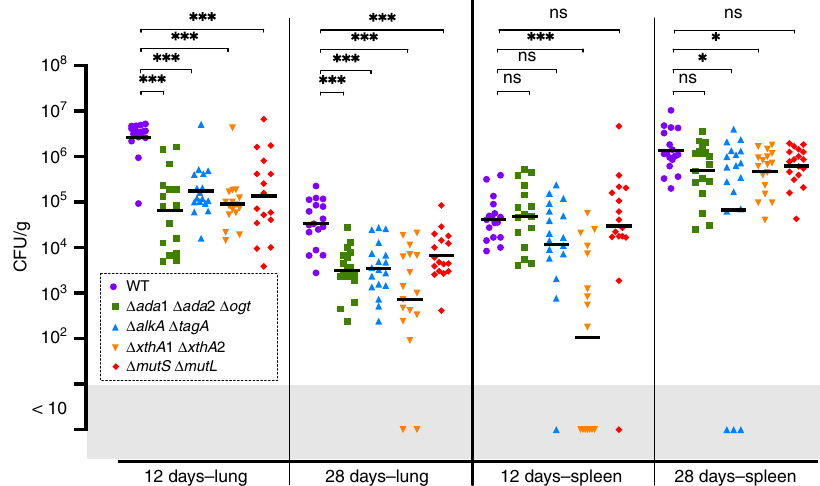
Fig. 8 Intranasal mice infection with B. abortus DNA repair deletion strains. Wild-type C57BL/6 mice received 2 × 10 4 CFU of B. abortus , as indicated in the section “ Methods ” . The mice were sacri fi ced at the selected time post infection. The data represent the number of CFU g − 1 of lung and spleen. These results are representative of two independent experiments with, in the same order than in the fi gure, n = 9 + 8, 8 + 8, 9 + 8, 8 + 8, 8 + 8 mice at 12 days and n = 9 + 8, 9 + 9, 9 + 9, 9 + 8, 9 + 9 mice at 28 days. Black lines correspond to mean values. A Mann – Whitney test was performed with p > 0.05 (ns non signi fi cant), p < 0.05 (*) and p < 0.001 (***). Source data are provided as a Source Data fi